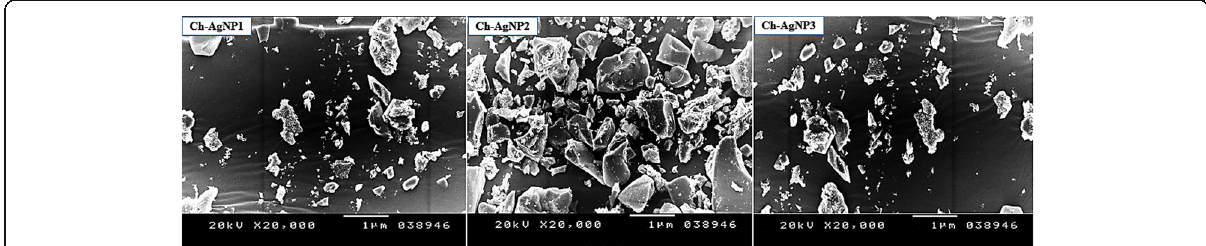
Fig. 1 SEM of the Ch-AgNPs. The right images show the particles in agitation form while the left images show the spherical particles with scale bar 1 μ m and magnification of × 20,000 at 20 Kv. Ch-AgNPs1 (0.1% Ag), Ch-AgNPs2 (0.2% Ag), and Ch-AgNPs3 (0.3%